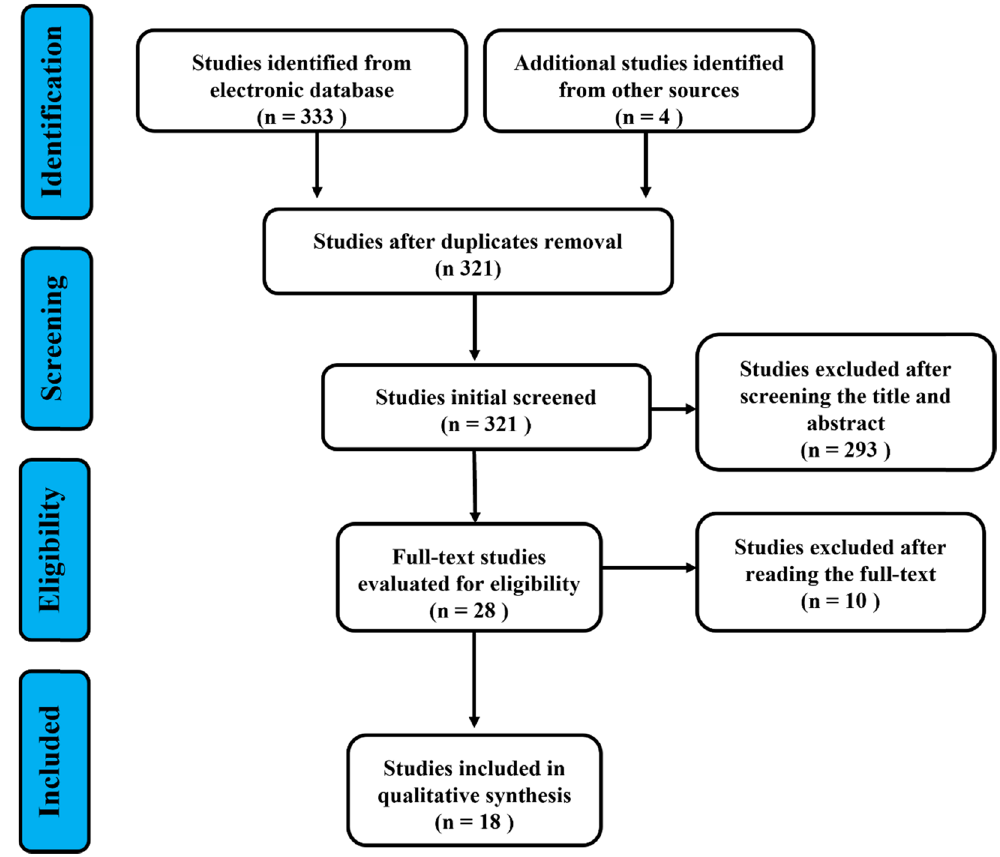
Figure 1: Publication searching fl ow - chart for serum Hcy level and